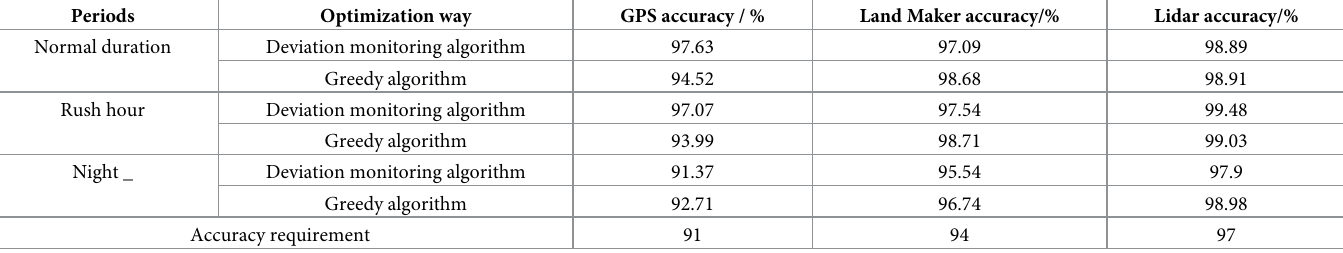
Table 3. Accuracy of two heuristic algorithms.